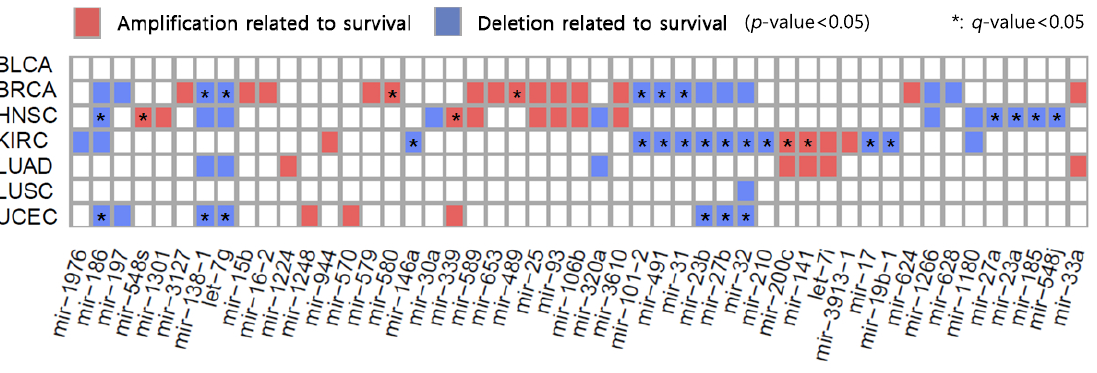
Figure 5. Survival analysis according to SCNA-miRNAs. Heatmaps showing miRNAs significantly affecting survival. Red and blue, the differences in patient survival when miRNA copy numbers were amplified and deleted,